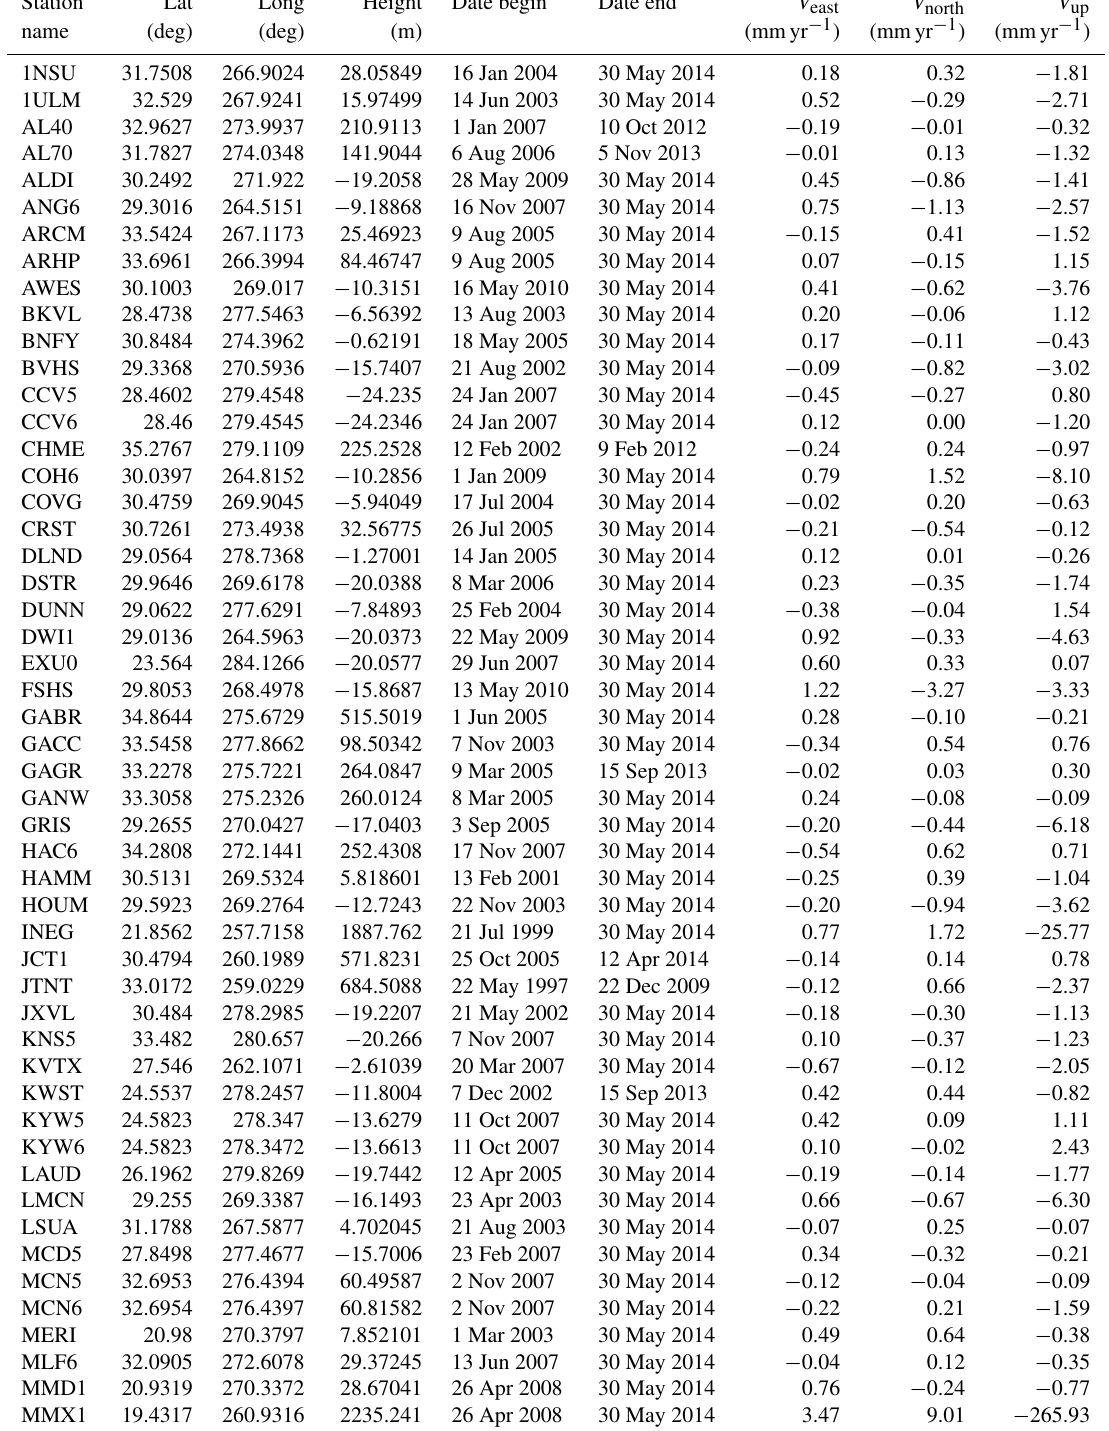
Table A1. Locations and velocities of 148 GPS stations within the Gulf of Mexico region with respect to SGOMRF.